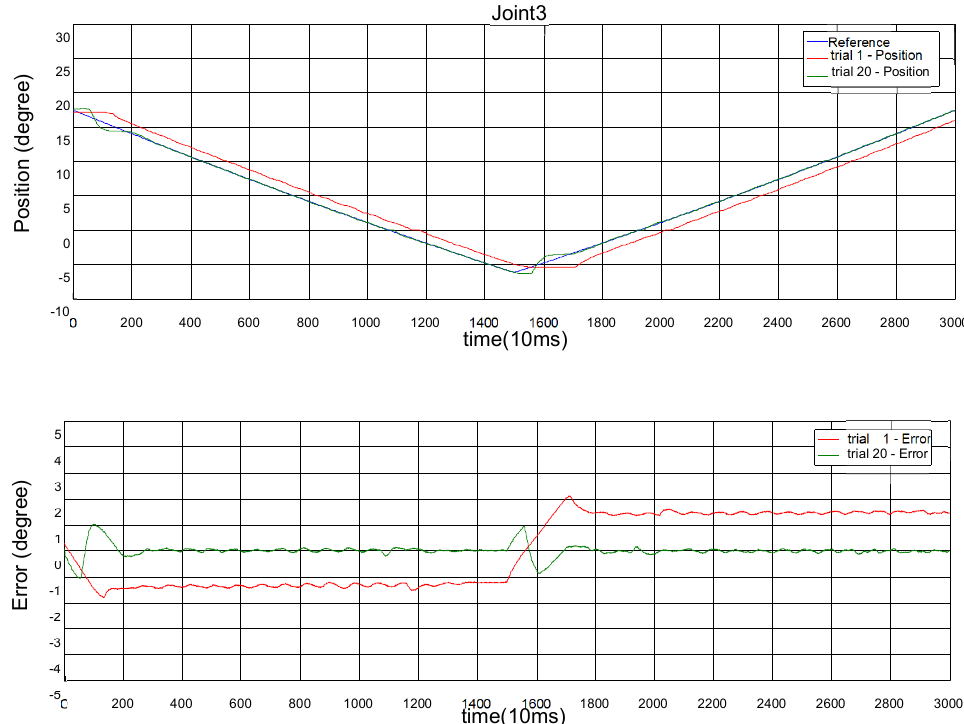
Figure 24. Trajectory 1—2nd-axis (load-on) ILC trial 1 and trial 20 tracking and error diagrams.